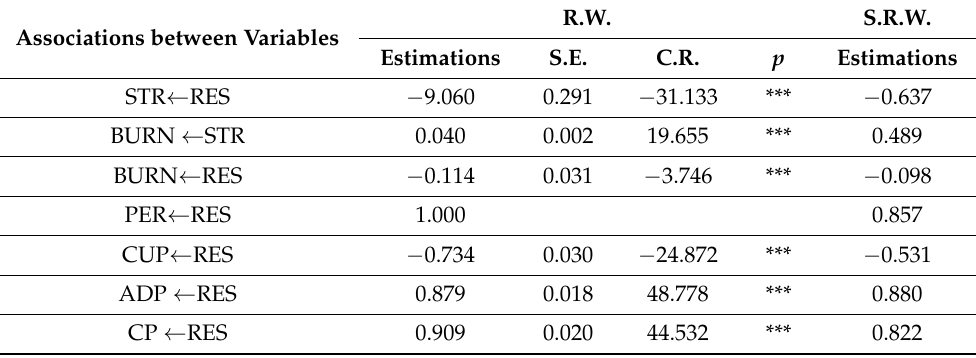
Figure 3. Structural equation model pertaining to participants who did not engage in more than 3 h of physical activity a week. Note: Resilience (RES); persistence/tenacity/self-efficacy (PER); control under pressure (CUP); adaptability and support networks (ADP); control and purpose (CP); spirit- uality (SP); number of study hours (NSH); burnout syndrome (BURN); stress (STR). Table 3. Values obtained from the proposed structural equation model for participants doing less than 3 h of physical activity per week.